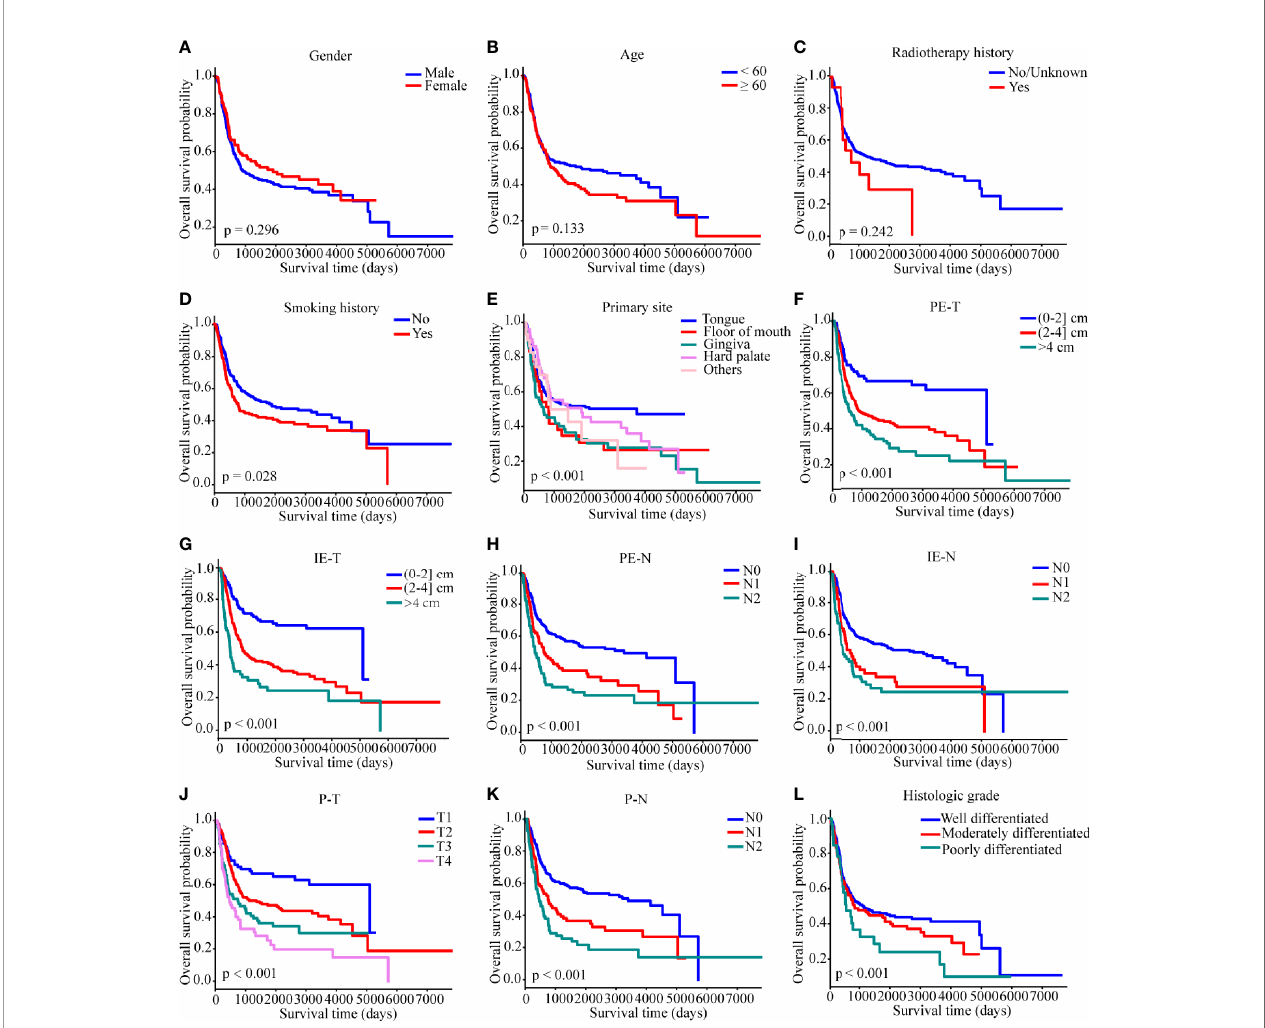
FIGURE 2 | Kaplan – Meier survival curves of overall survival in the SYSUCC cohort. (A) gender, (B) age, (C) radiotherapy history, (D) smoking history, (E) primary site, (F) PE-T, (G) IE-T, (H) PE-N, (I) IE-N, (J) P-T, (K) P-N, (L) histologic grade. Survival curves were compared by the log-rank test, and p < 0.05 was considered as statistically signi fi cant. PE-T, physical examination-tumor size; IE-T, imaging examination-tumor size; PE-N, physical examination-nodal involvement; IE-N, imaging examination-nodal involvement; P-T, pathological tumor stage; P-N, pathological nodal involvement stage; T, tumor; N, lymph